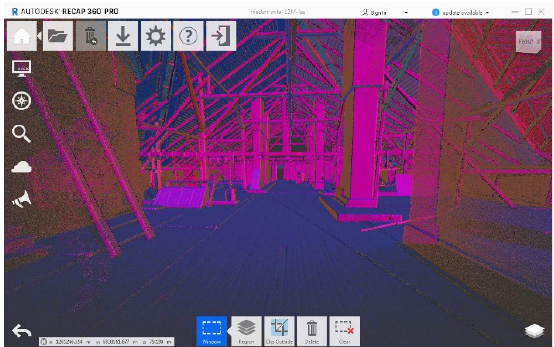
Figure 2. Indexation of point clouds in Autodesk-native file using Recap 360 Pro